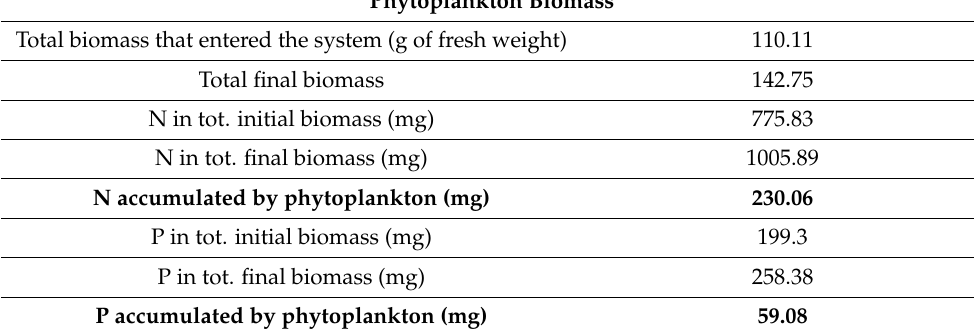
Figure 9. Cumulative total phosphorus removed from 70 L of aquaculture effluent every 12 h. N (Night) indicates the Total Phosphorus removed between 8:00 pm and 8:00 am; D (Day) indicates the Total Phosphorus removed between 8:00 am and 8:00 pm. The graph shows the average of three replicates. Table 2. Biomass gained and nutrients accumulated by phytoplankton during the experiment. The total biomass produced was estimated from the phytoplankton filtered from the water samples collected twice a day from the inlet and outlet